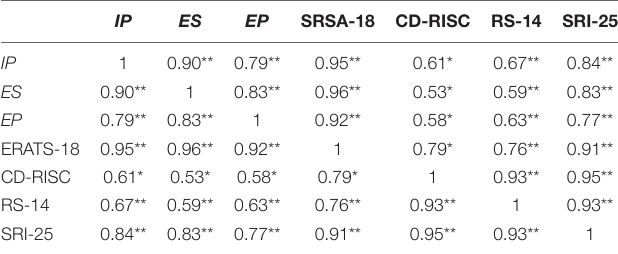
TABLE 5 | Correlations between SRSA-18 and subdimensions with CD-RISC, RS-14, SRI-25.